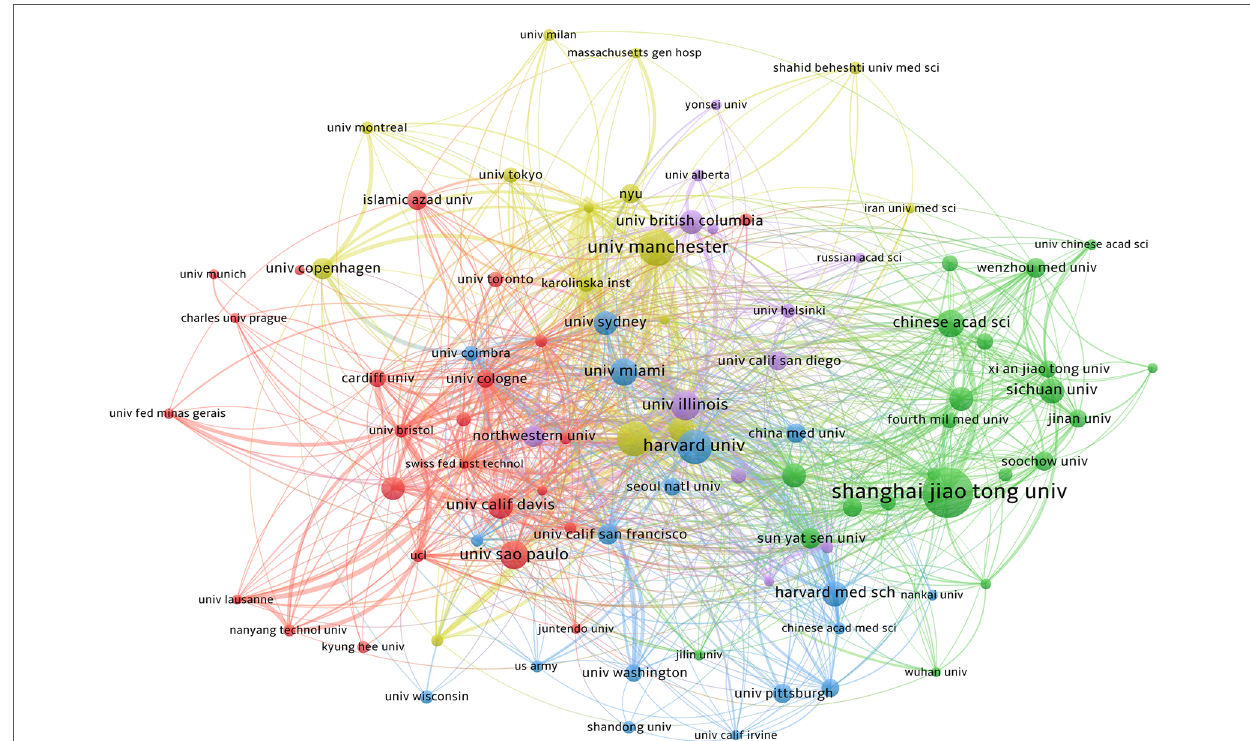
FIGURE 4 The co-authorship network of institutions. A total of 4,123 institutions participated in the study. The network of co-authors was divided into fi ve clusters of different colors. The red cluster is dominated by American institutions, and the Harvard University has the greatest impact. The green cluster is dominated by Chinese